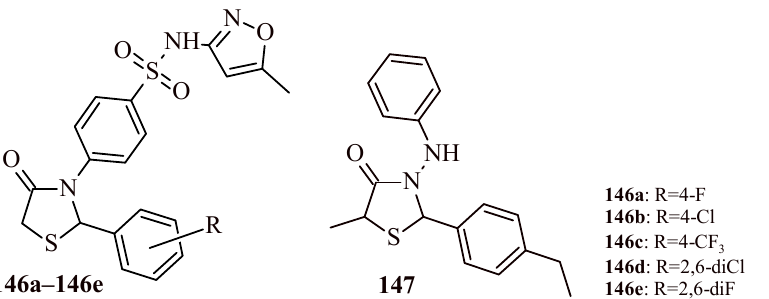
Figure 55. The 2-Arylthiazolidin-4-ones with antimycobacterial activity. Šlachtova et al. conducted design and synthesis of a series of A series of 2-aryl-5-methylthiazolidin-4-ones was synthesized by Ekinci et al. All compounds of this series were evaluated for antimycobacterial activity in vitro against M.